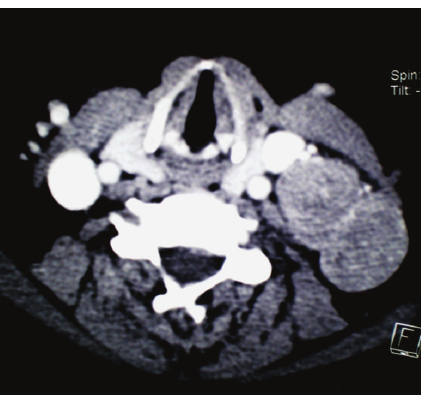
Figure 1: Contrast enhanced neck CT scan axial cup: left lateral jugular lymphadenopathy with heterogenic tissue density.